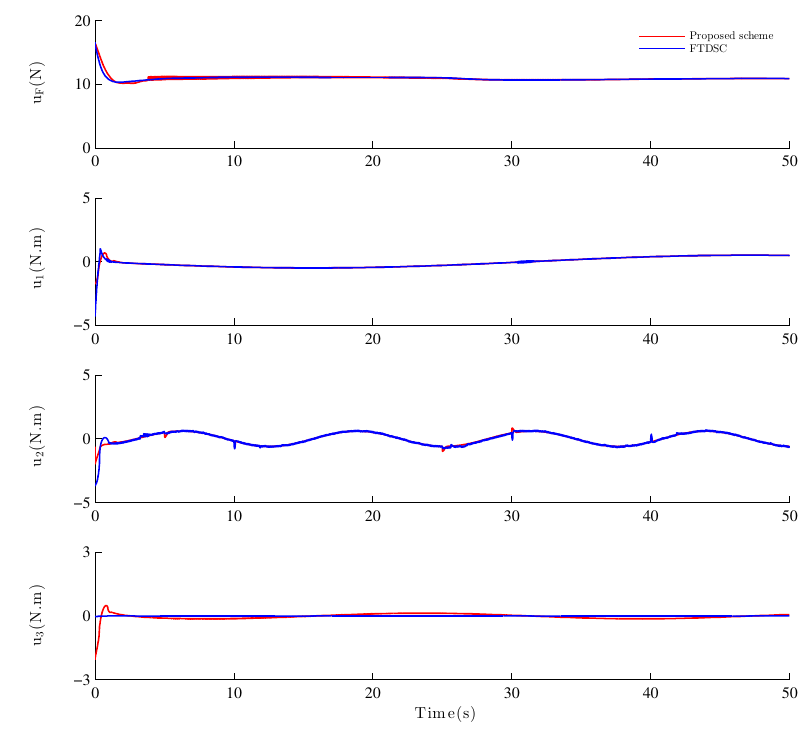
Figure 5. Time response of control